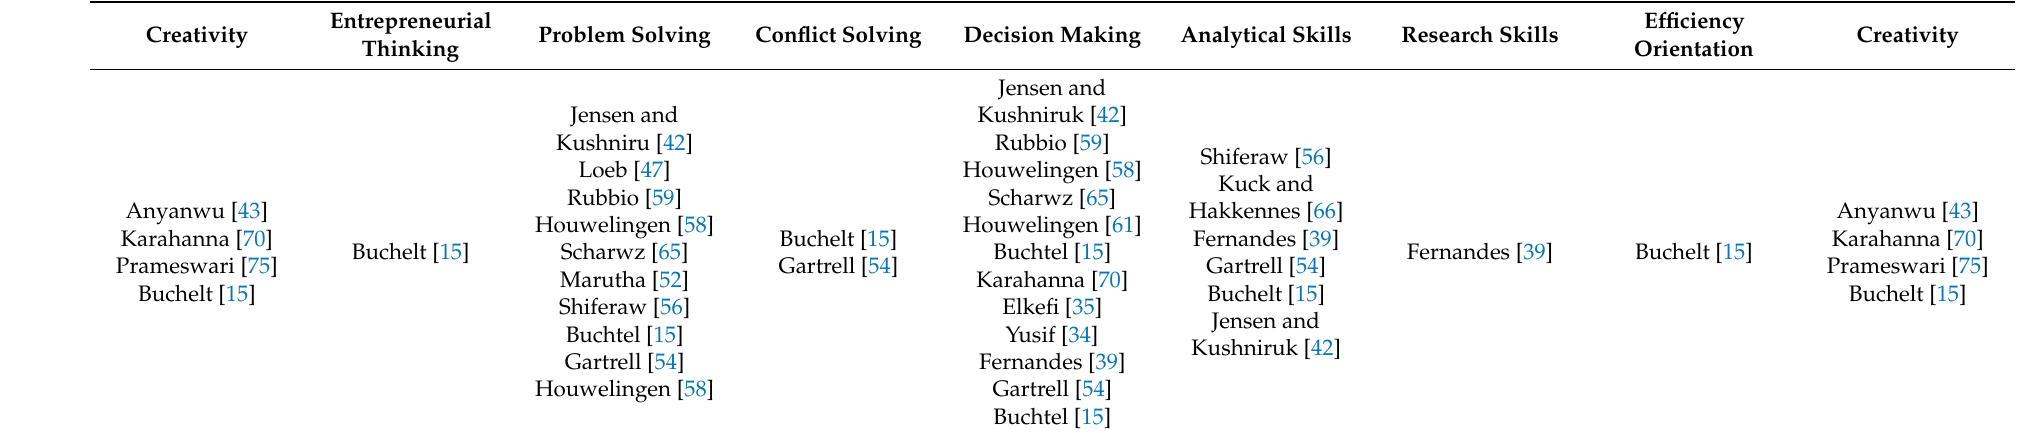
Table 8. Methodological competencies for adopting H4.0 ICTs and cited